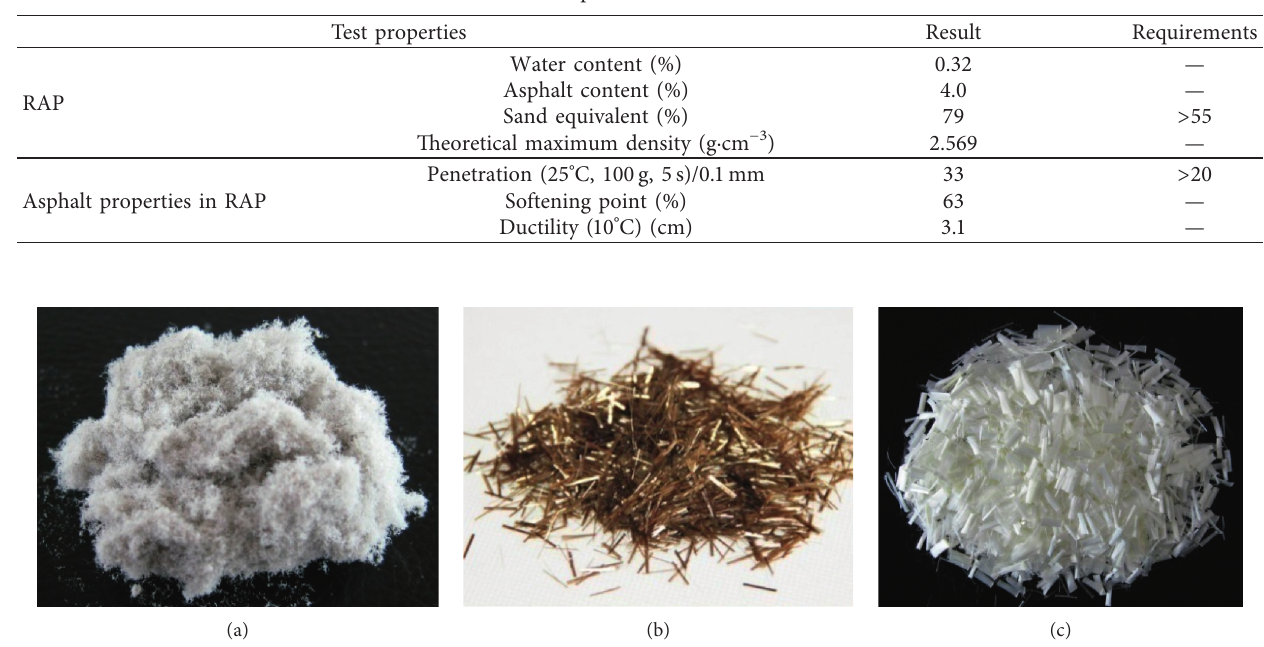
Table 3: Experiment results of RAP.